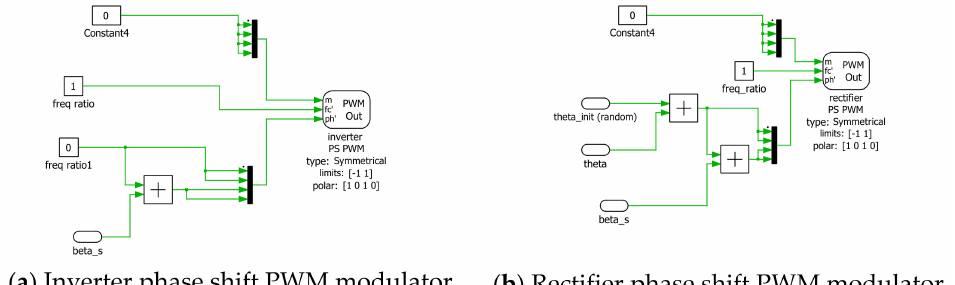
Figure 27. TPS phase shift PWM modulator signal connections when TPS control in separate inverter and rectifier control hardware.